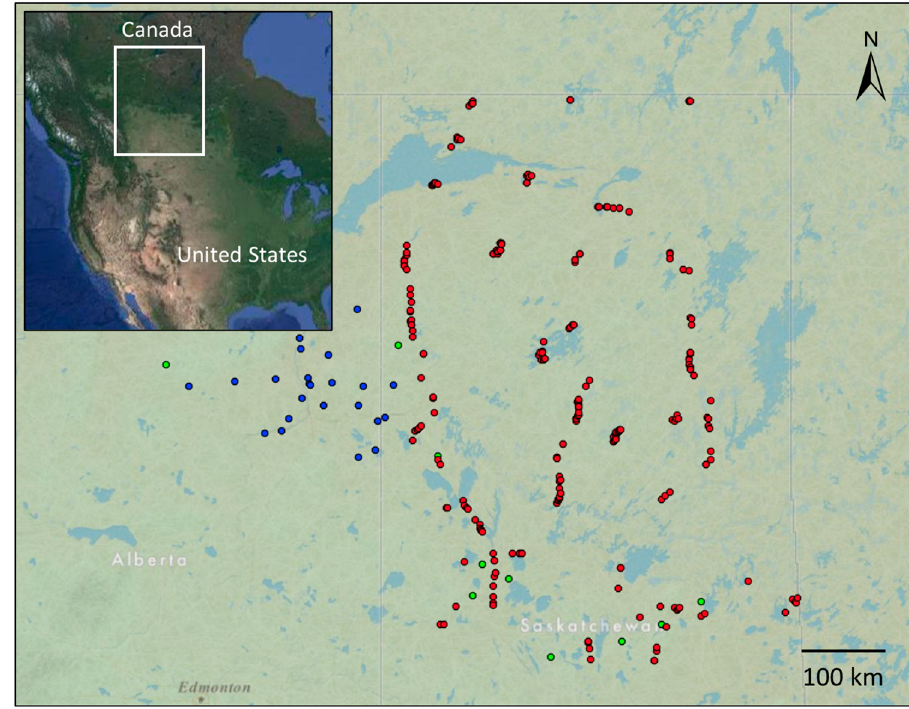
Figure 1. Location of study sites across Alberta and Saskatchewan (n = 297) used in gradient forest analysis. Study sites are coloured based on their survey of origin, with blue indicating WBEA survey sites (n = 25), sampled between 2011 and 2012, green indicating NFI survey sites (n = 10), sampled between 2002 and 2006, and red indicating SK-FEC survey sites (n = 262), sampled between 2000 and 2010. The inset depicts the location of the study area in north America.